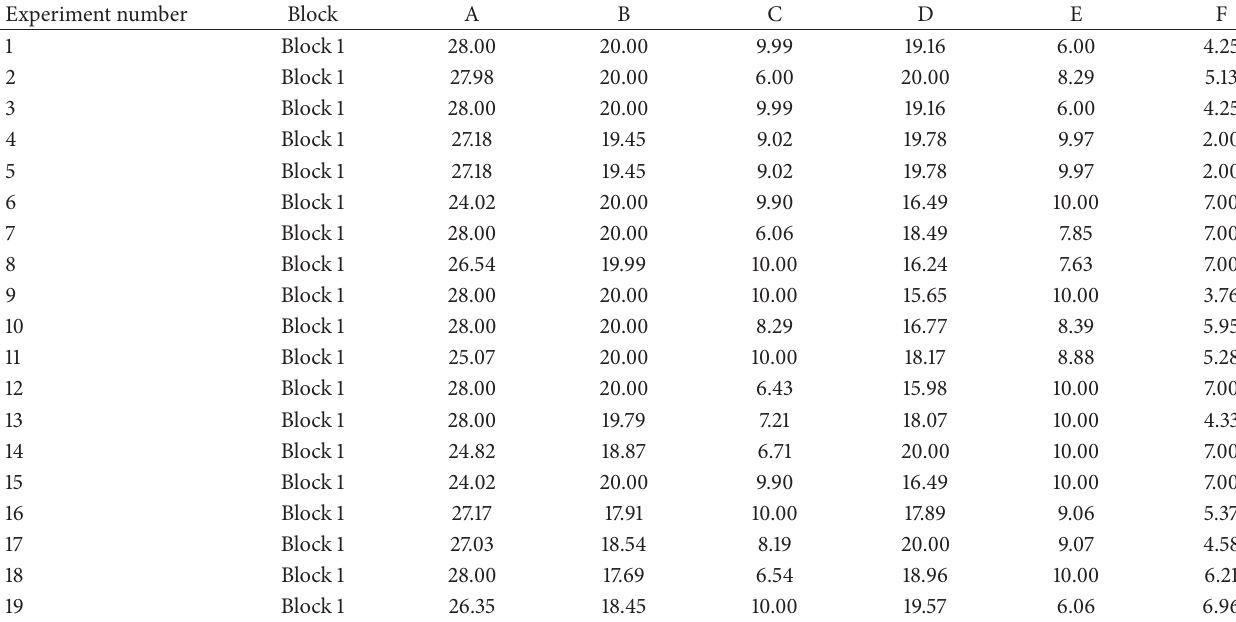
Table 2: Matrix of D-optimal mixture design.